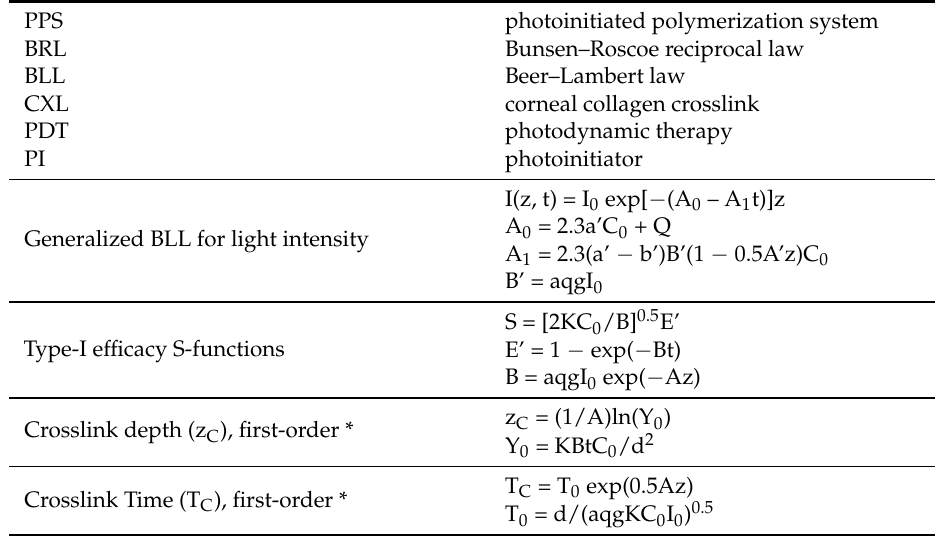
Table 1. Abbreviations and